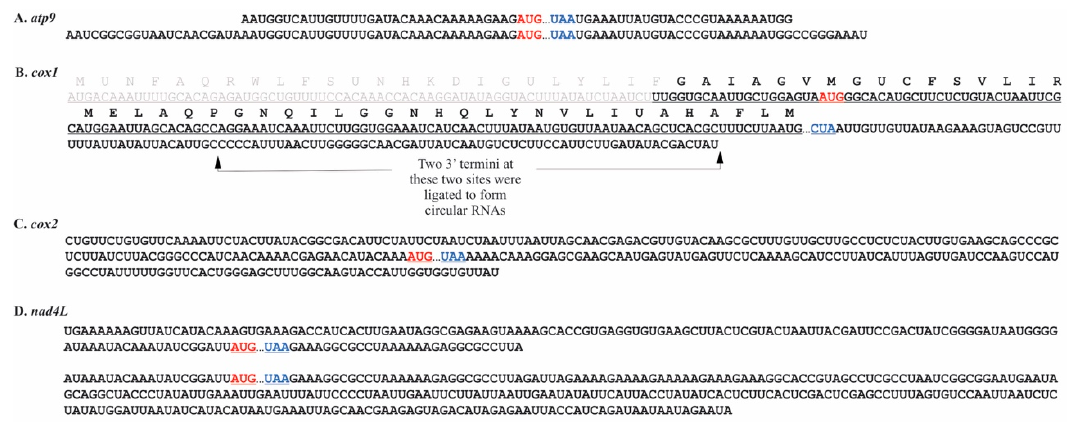
Figure 7. Naturally circularized mRNAs found in C. vulgaris mitochondria. Start codons are colored red, stop codons blue, and truncated portions of coding regions grey. ( A ). Two circularized versions of full-length transcripts were detected for atp9 . ( B ). Two circularized cox1 transcripts were detected. Both had the same 5 ′ end but different termini on the 3 ′ ends. ( C ). A single circularized version of the cox2a transcript was detected. ( D ). Two circularized full-length nad4L transcripts of different lengths were detected.